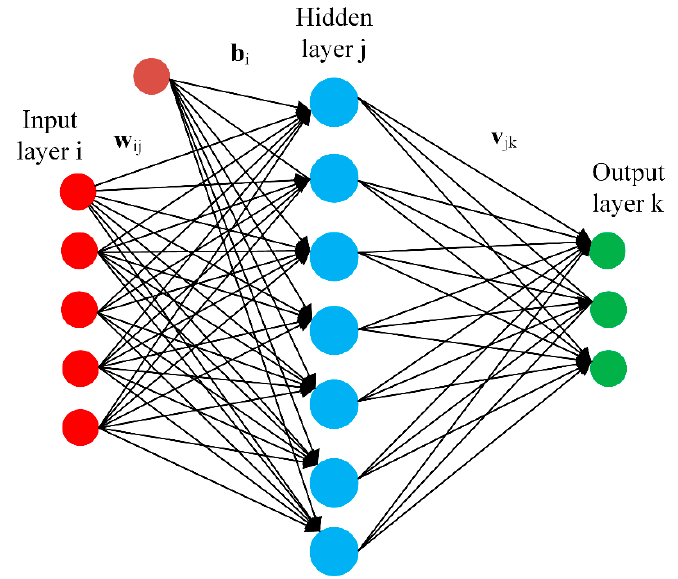
Figure 1. Feedforward neural network structure.